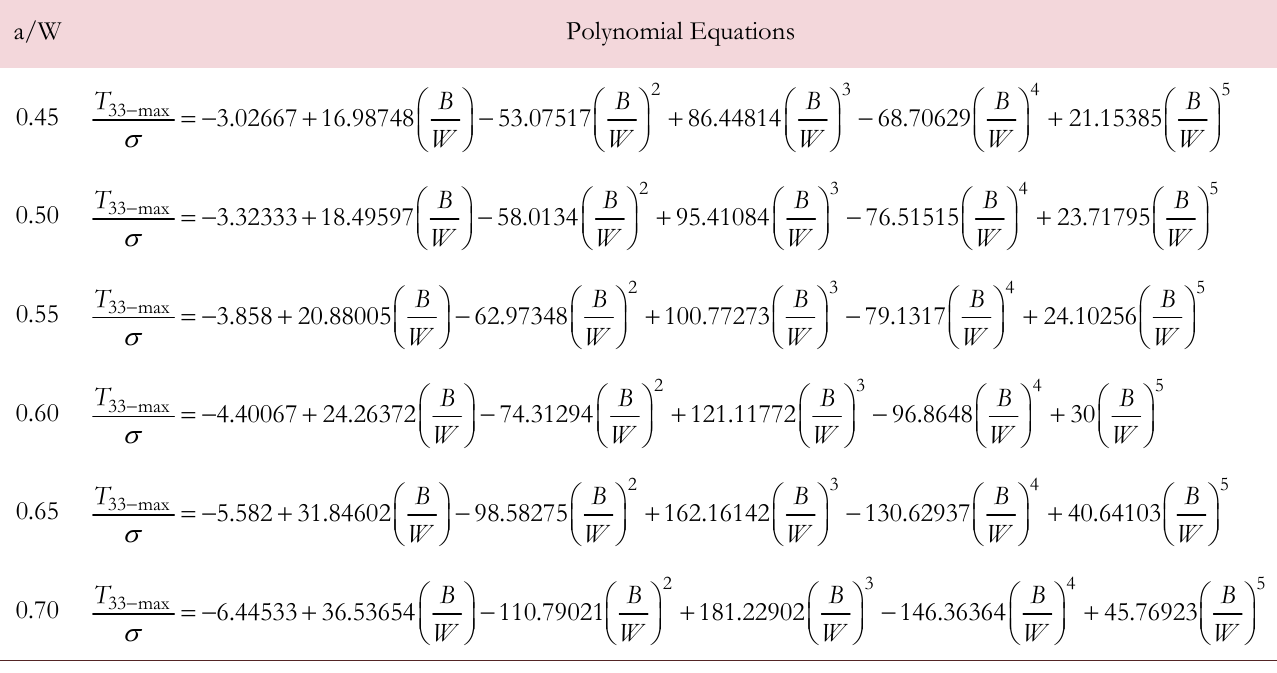
Table 3: Polynomial equations for T 33 .